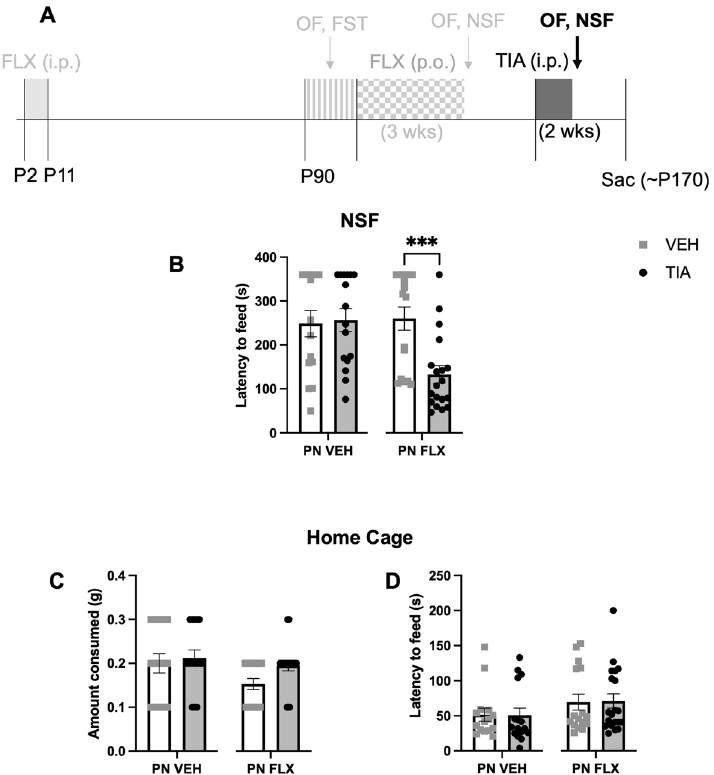
Figure 5. Decreased anxiety-like behavior in the novelty suppressed feeding task following adult tianeptine treatment in C57 PNFLX mice. ( A ) Timeline of experiment: The window for developmental administration of fluoxetine as well as prior phases of the experiment are in faded light grey; Black and dark grey indicate tianeptine administration in adulthood and follow up NSF and OF tests. ( B ) Latency to feed in NSF in C57 mice (PNVEH: unpaired t-test, p = 0.8455; PNFLX: unpaired t-test, *** p = 0.0004). ( C ) Amount of food consumed in the home cage in a 5-min period in C57 mice (PNVEH: unpaired t-test, p = 0.6599; PNFLX: unpaired t-test, p = 0.0679). ( D ) Latency to eat in the home cage in C57 mice (PNVEH: unpaired t-test, p = 0.7460; PNFLX: unpaired t-test, p = 0.9435). Light gray squares represent adult vehicle-treated animals. Black circles and grey bars represent adult tianeptine-treated animals. N = 15 PNVEH-VEH, 16 PNVEH-TIA, 17 PNFLX-VEH, 19 PNFLX-TIA. Bars represent mean. Error bars represent standard error. * p < 0.05, ** p < 0.01, *** p < 0.001, **** p <